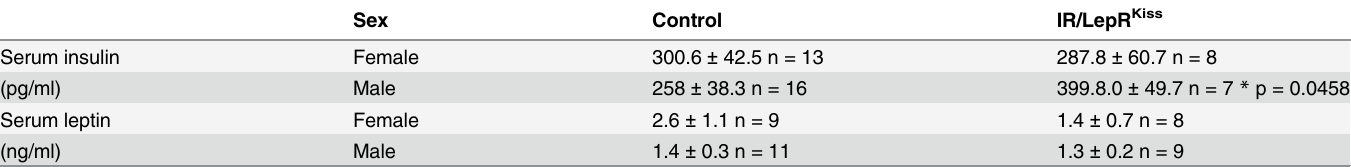
Table 5. Overnight fast serum insulin and